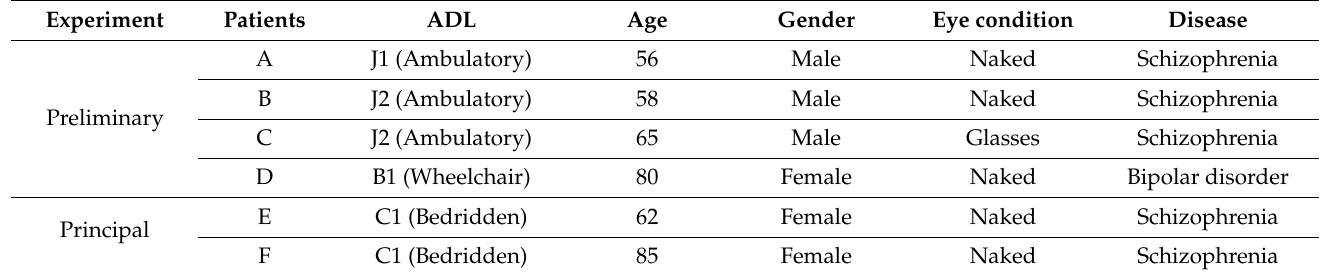
Table 1. Characteristics of patients.